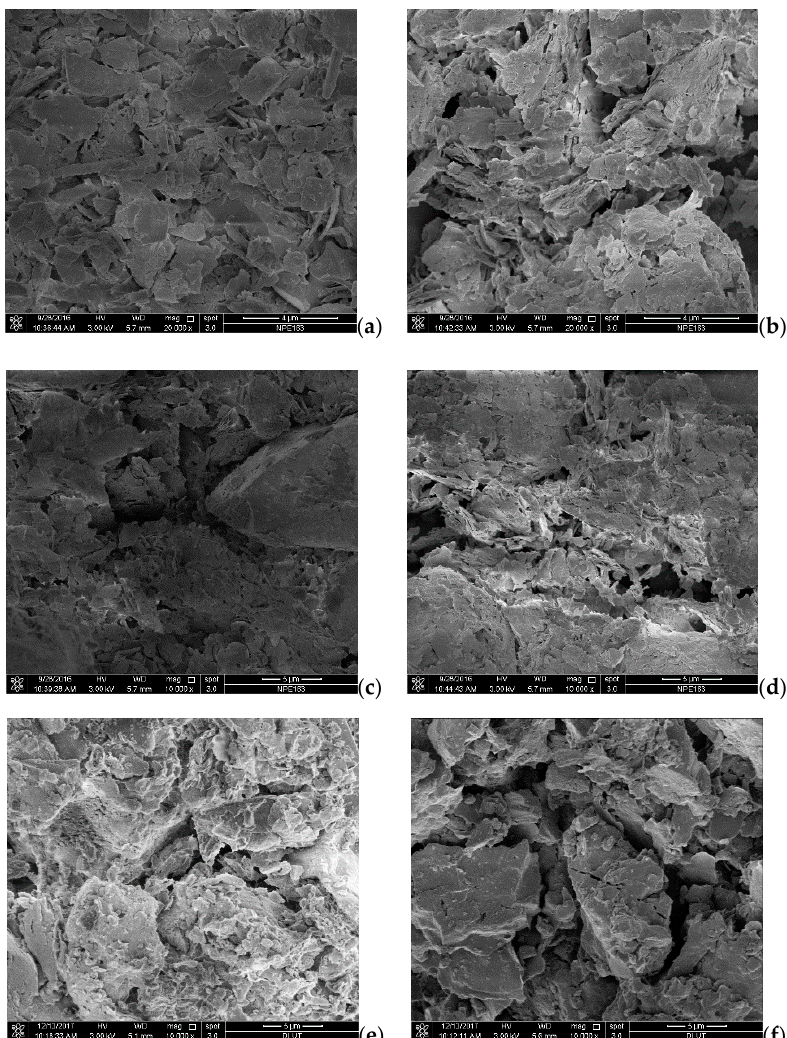
Figure 3. SEM images of marine sediments: ( a ) S-1; ( b ) S-2; ( c ) S-3; ( d ) S-4; ( e ) S-5; ( f ) artificial silt.